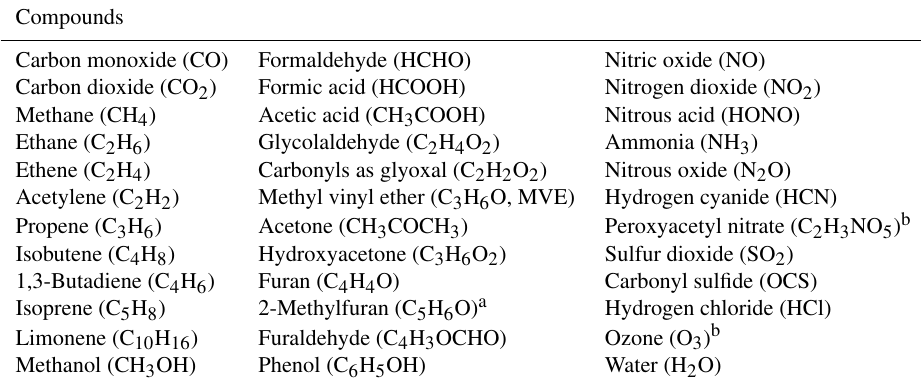
Table 1. Compounds previously detected in biomass burning studies using FTIR methods (Akagi et al., 2013, 2014; Alves et al., 2010; Burling et al., 2010, 2011; Goode et al., 1999, 2000; Karl et al., 2007; Christian et al., 2003, 2004; Selimovic et al., 2018; Stockwell et al., 2014; Yokelson et al., 1996, 1997, 2009; Hatch et al., 2017; Gilman et al., 2015).